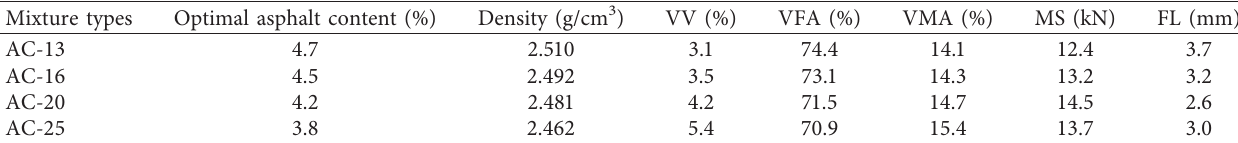
Table 3: Design data of the asphalt mixtures used in this study.